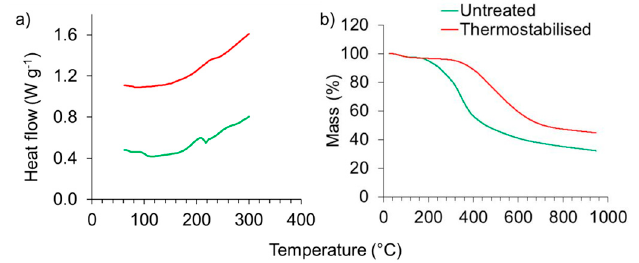
Figure 5. DSC ( a ) and TGA ( b ) curves of organosolv lignin particles prior to and after thermostabilisation.